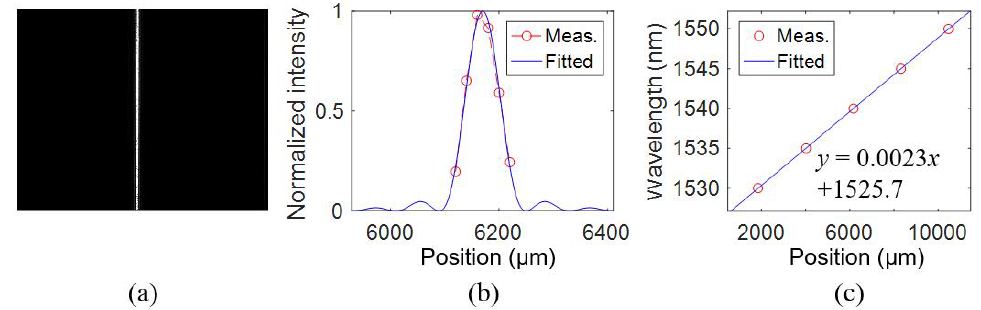
Figure 11. Measured results of WSL2. ( a ) Spectral line at 1540 nm. ( b ) Measured and fitted far-field distributions with an FWHM of 0.16 nm at 1540 nm. ( c ) Measured and fitted wavelengths at different pixel positions.